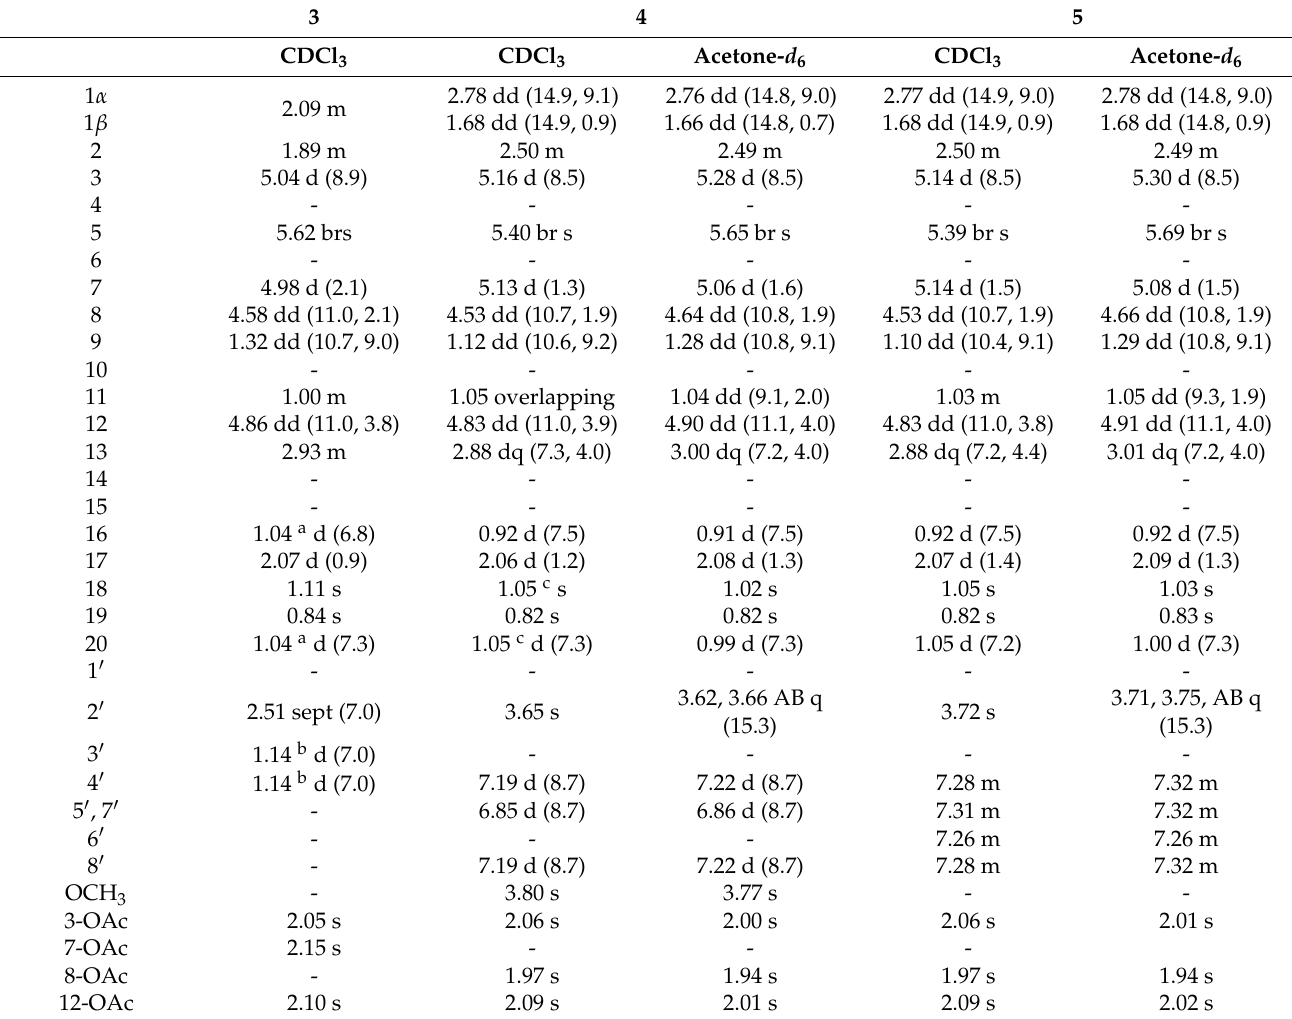
Table 2. 1 H NMR data of compounds 3 – 5 at 600 MHz ( δ in ppm, J in